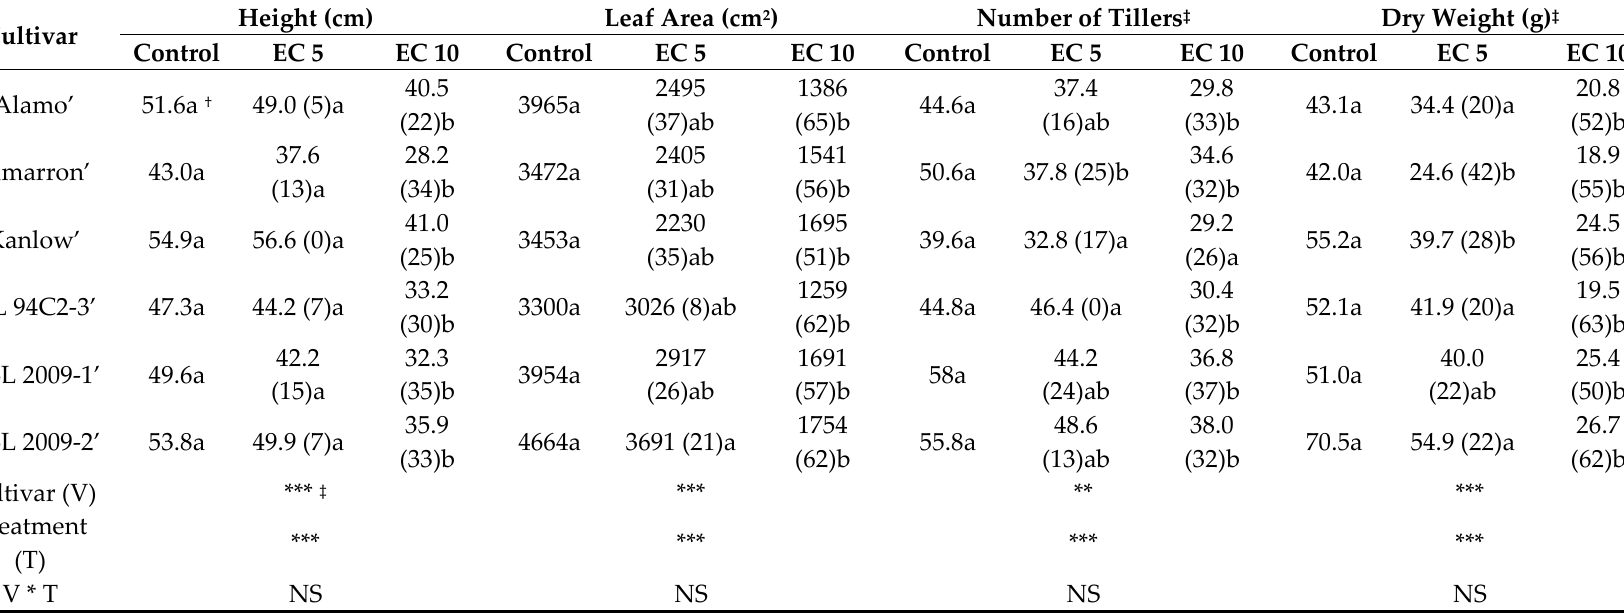
Table 1. Height, leaf area, number of tillers, and dry weight of six switchgrass cultivars irrigated with salt solutions at an electrical conductivity (EC) of 5.0 dS·m −